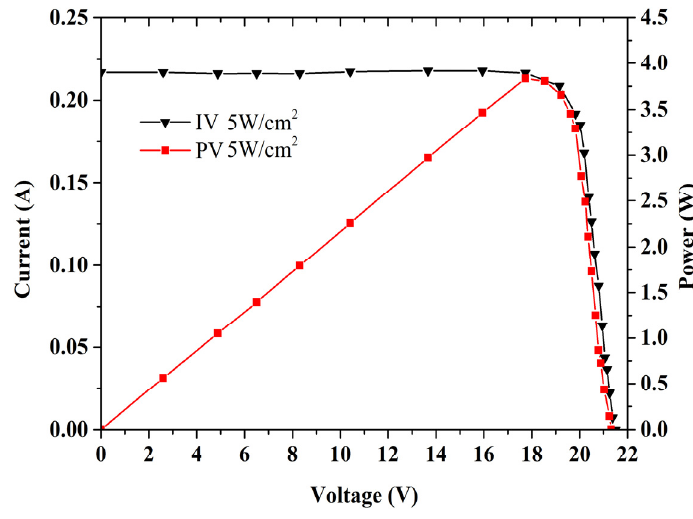
Figure 11. I-V and P-V curves of GaAs PV array converter.